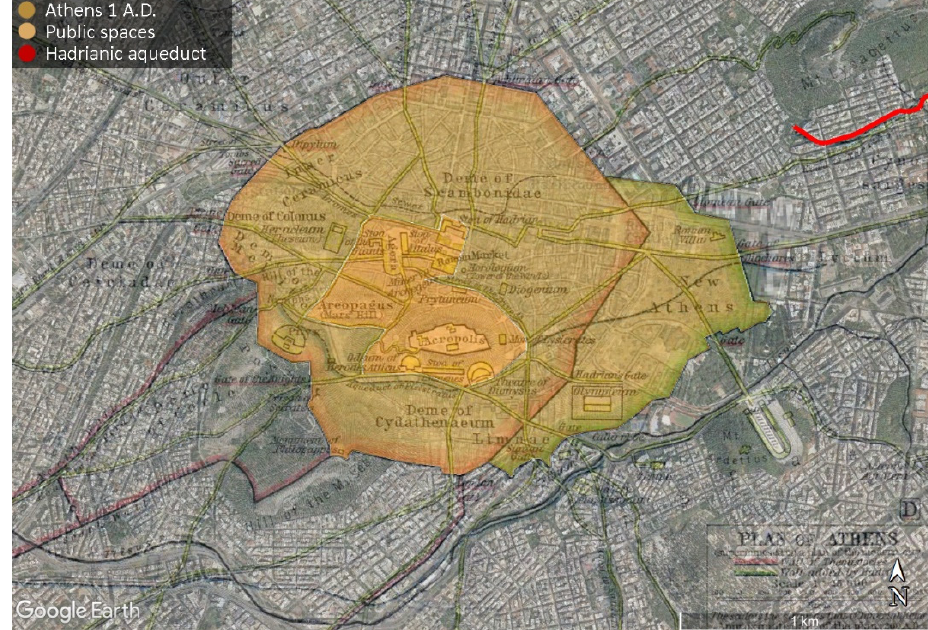
Figure 29. Athens in the Roman era. Data adapted by [140] to Google Earth [71].